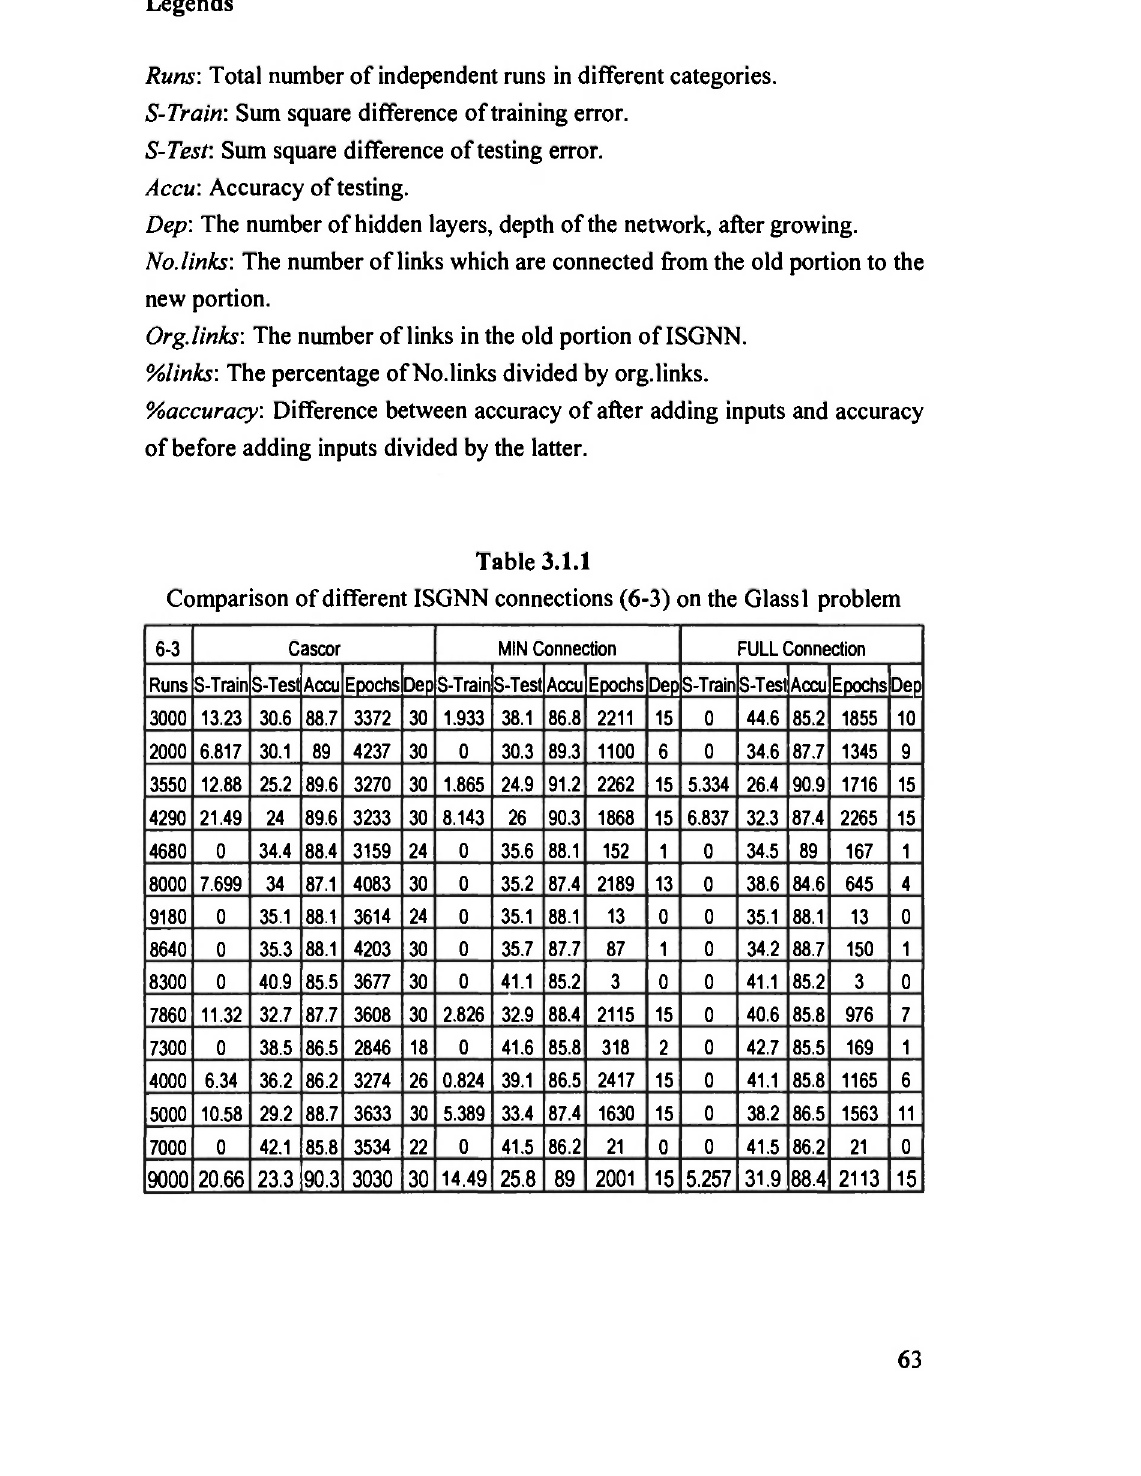
Comparison of different ISGNN connections (6-3) on the Glass 1 problem 6-3 Cascor MIN Connection FULL